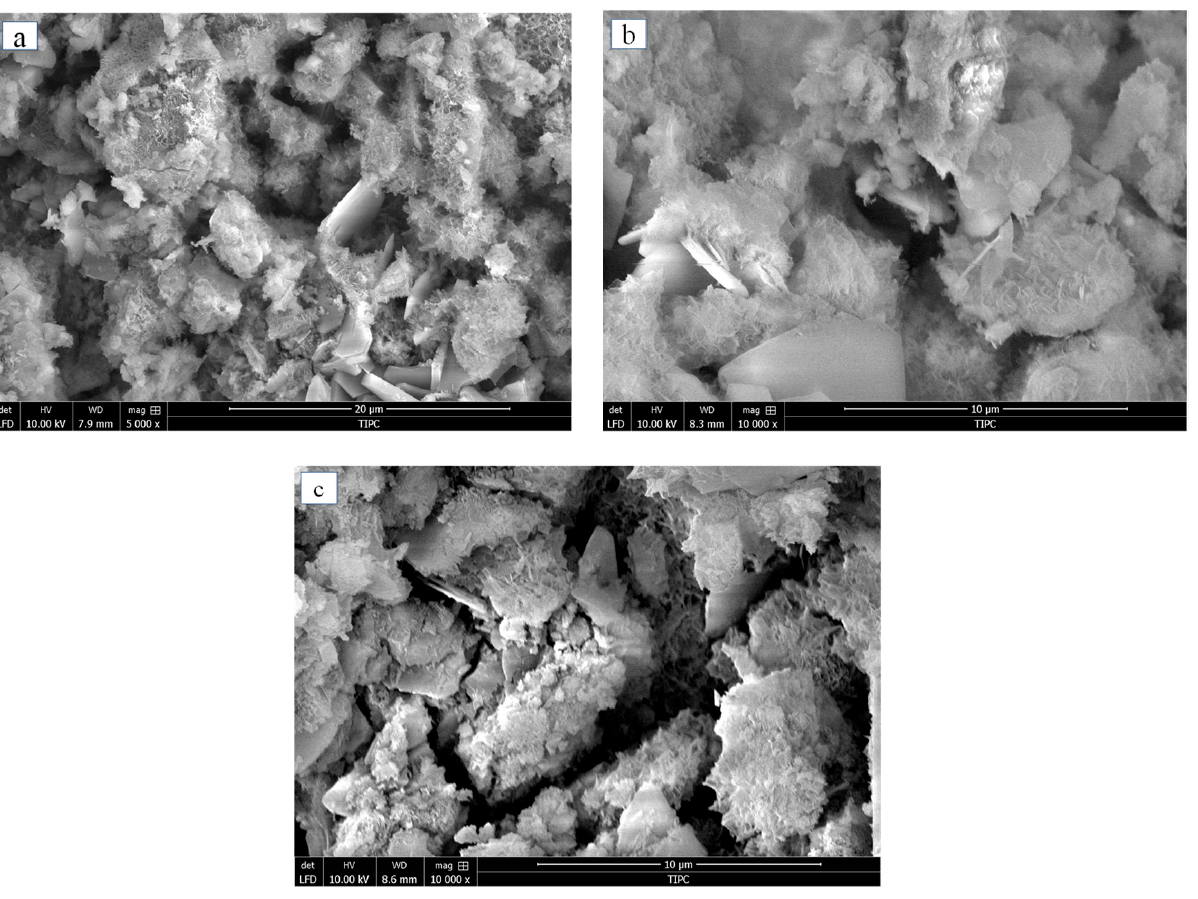
Figure 11. SEM images of samples with different solid content. ( a ) b/w ratio of 1:4, solid content of 72%,curing time of 7 d; ( b ) b/w o of 1:4, solid content of 75%,curing time of 7 d; ( c ) b/w of 1:4, solid content of 78%,curing time of 7 d;